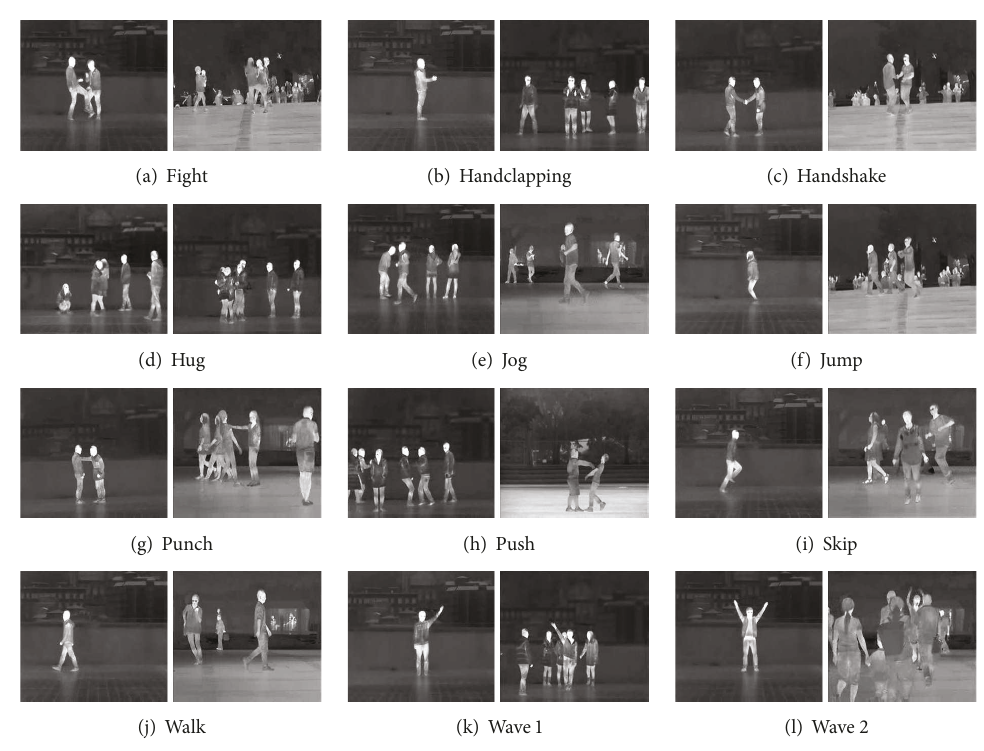
Figure 4: Example images from video sequences in the InfAR